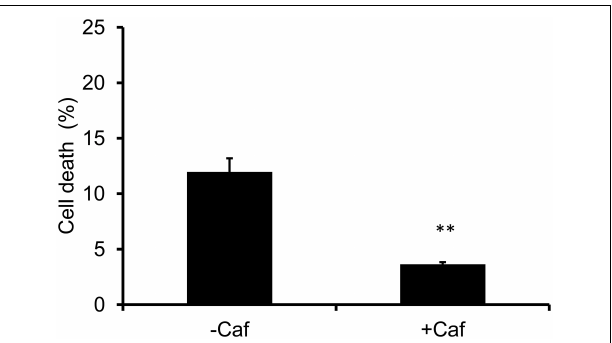
FIGURE 7 | Caffeine reduces cell death induced by high-dose UV-B. BY-2 cells pretreated with 5mM caffeine ( + Caf) or without caffeine (–Caf) for 1h were exposed to UV-B (2960 J m − 2 ) and cultured for 24h. Dead cells stained with Evans blue were counted. Error bars show SD ( n = 3 ). Asterisks indicate a significant difference from –Caf ( P < 0 . 01